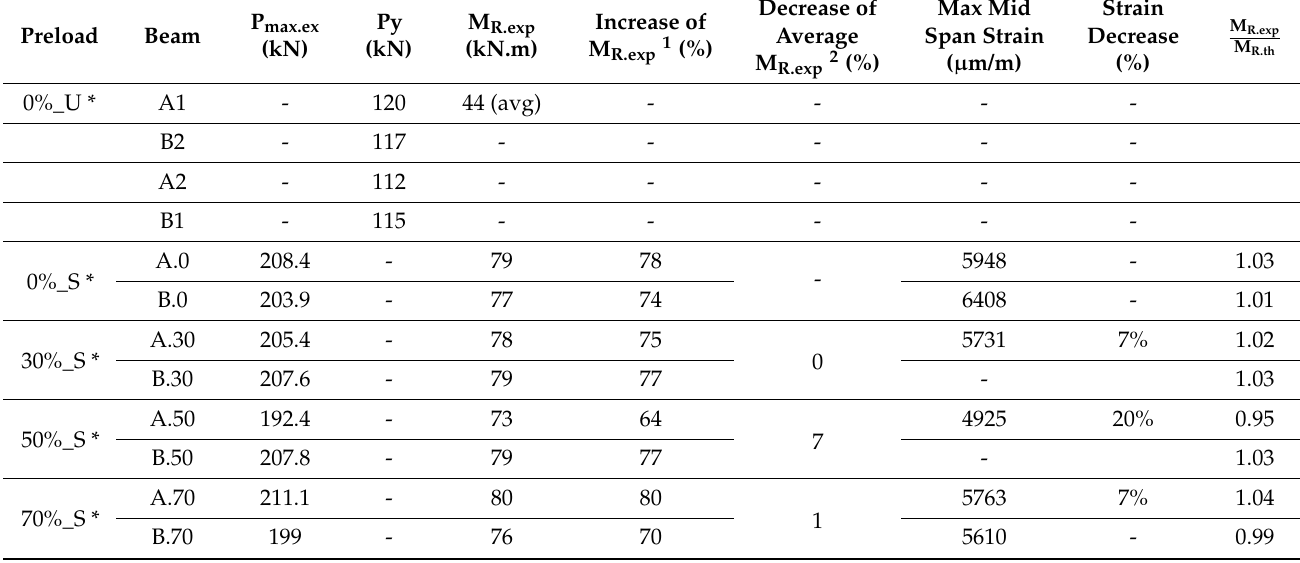
Table 5. Experimental